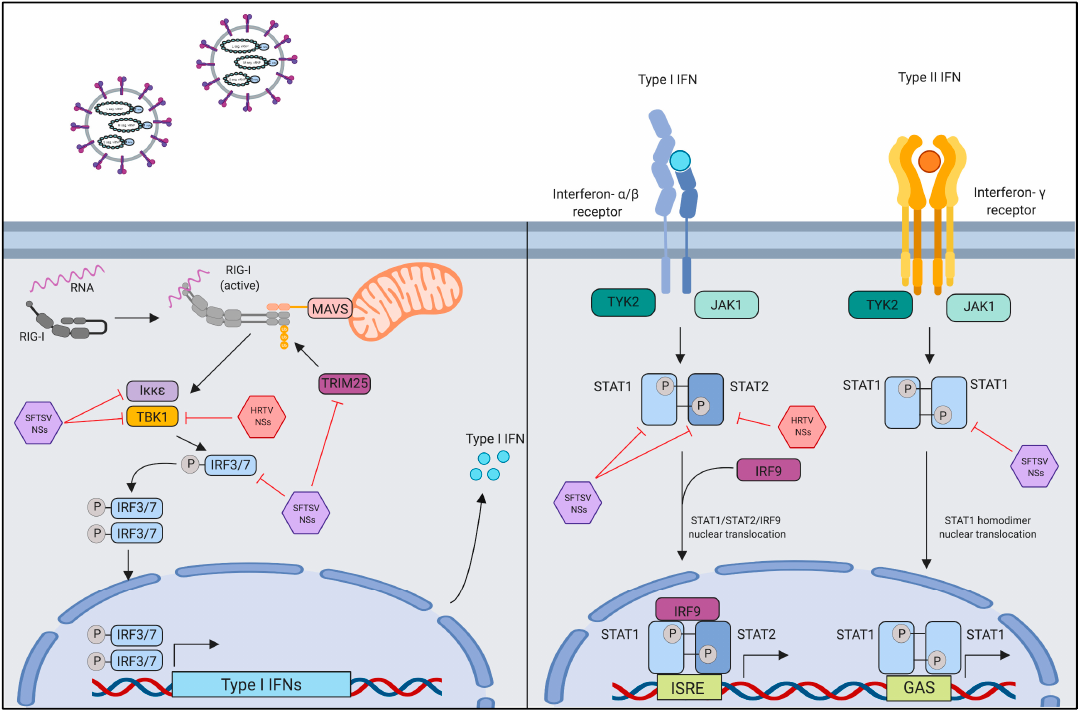
Figure 3. Antagonism of the innate immune response by SFTSV and HRTV. The non ‐ structural proteins of SFTSV and HRTV are responsible for the antagonism of the host interferon response. SFTSV NSs blocks signaling cascades through sequestration of host proteins into viral inclusion bodies; HRTV does not form inclusion bodies, but still interacts and restricts induction of type ‐ I interferons. The SFTSV NSs and HRTV NSs also differentially antagonize the signal component of the interferon response through direct interaction with STAT proteins thereby preventing downstream production of ISGs.